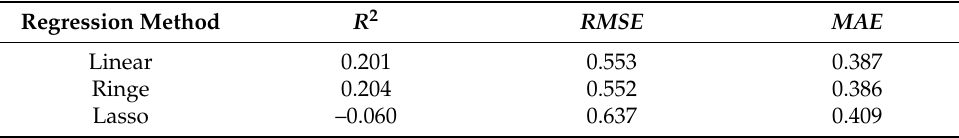
Table 3. Statistical indicators of the results calculated by MLR models. Regression